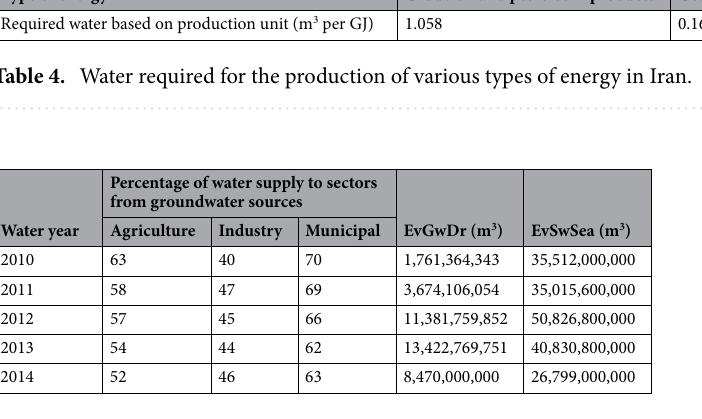
Table 5. Variables obtained from